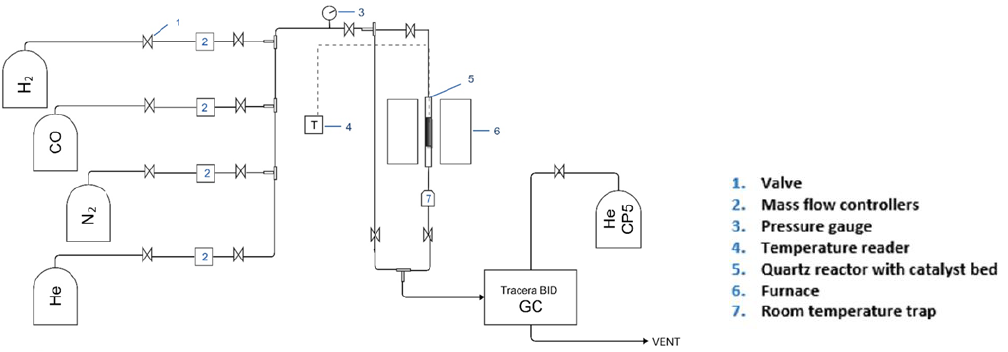
Figure 1. Experimental rig setup.